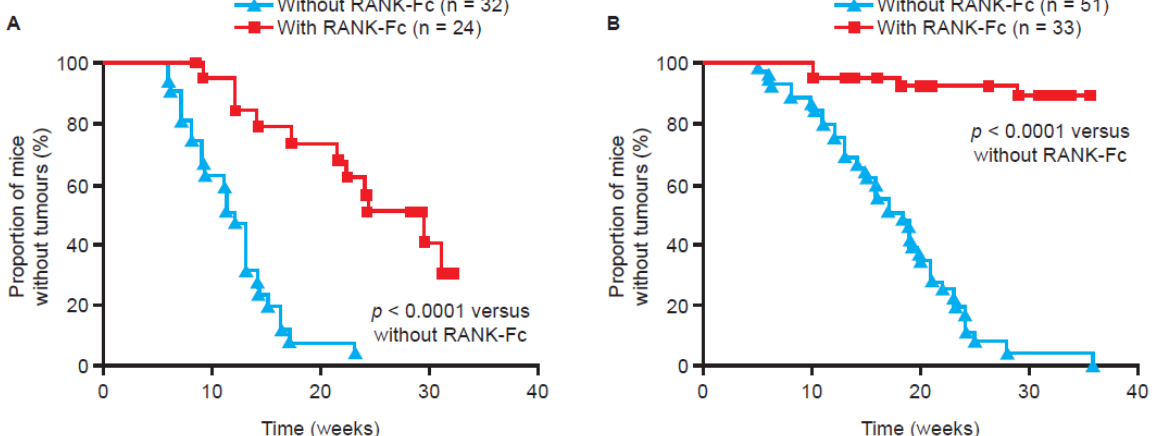
Figure 3. Blockade of RANK through pharmacological inhibition or genetic inactivation inhibits tumour formation in mice. Tumour growth following the administration of the carcinogen 7,12-dimethylbenzanthracene (DMBA) and the progesterone derivative medroxyprogesterone acetate (MPA), with and without concomitant treatment with the RANK inhibitor RANK-Fc, in ( A ) transgenic mice overexpressing RANK and ( B ) wild-type mice [29]. Reprinted from [29].